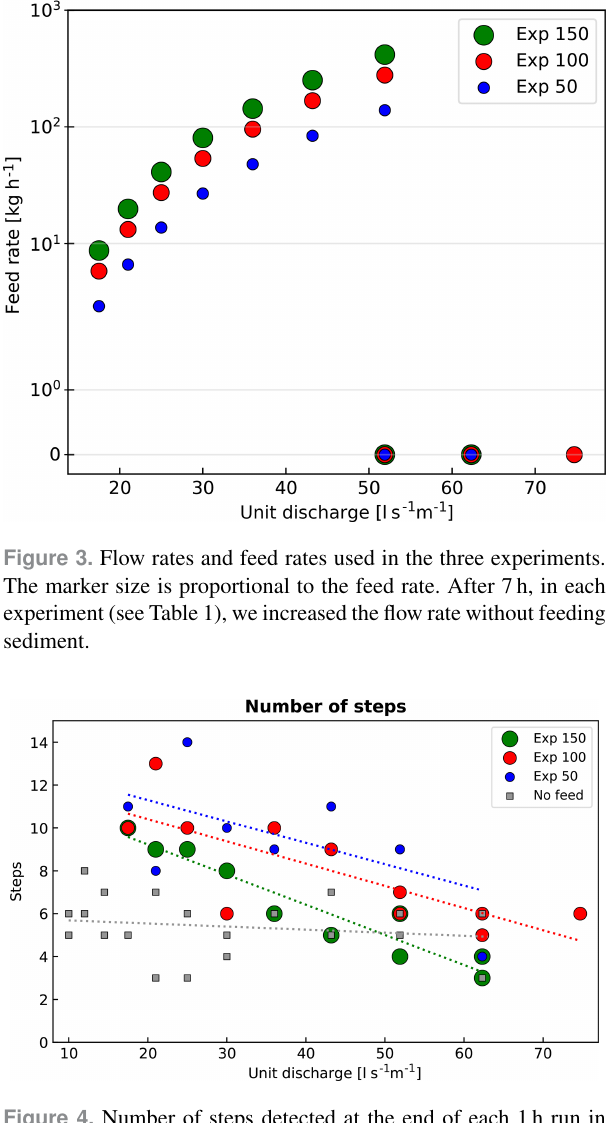
Figure 4. Number of steps detected at the end of each 1h run in the feed experiments, shown with circles, and in the no-feed exper- iments from Saletti and Hassan (2020a), shown with squares. The size of the circles is proportional to the sediment feed rate. Dashed lines are the best-fit lines for the experiments; the values of R 2 are 0.36, 0.60, and 0.91 for Experiments 50, 100, and 150, respectively. The best-fit line for the no-feed experiments is almost flat but with R 2 < 0 .